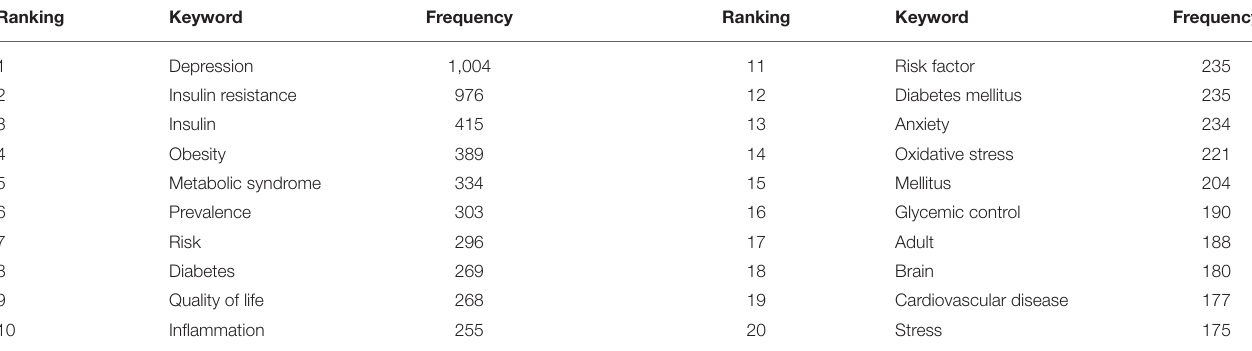
TABLE 4 | Top 20 keywords in terms of frequency.